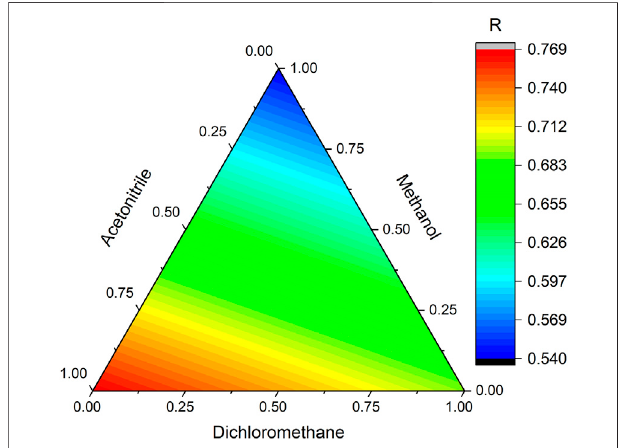
FIGURE 1 | Response surface for the overall desirability obtained from the solvent mixture design experimental